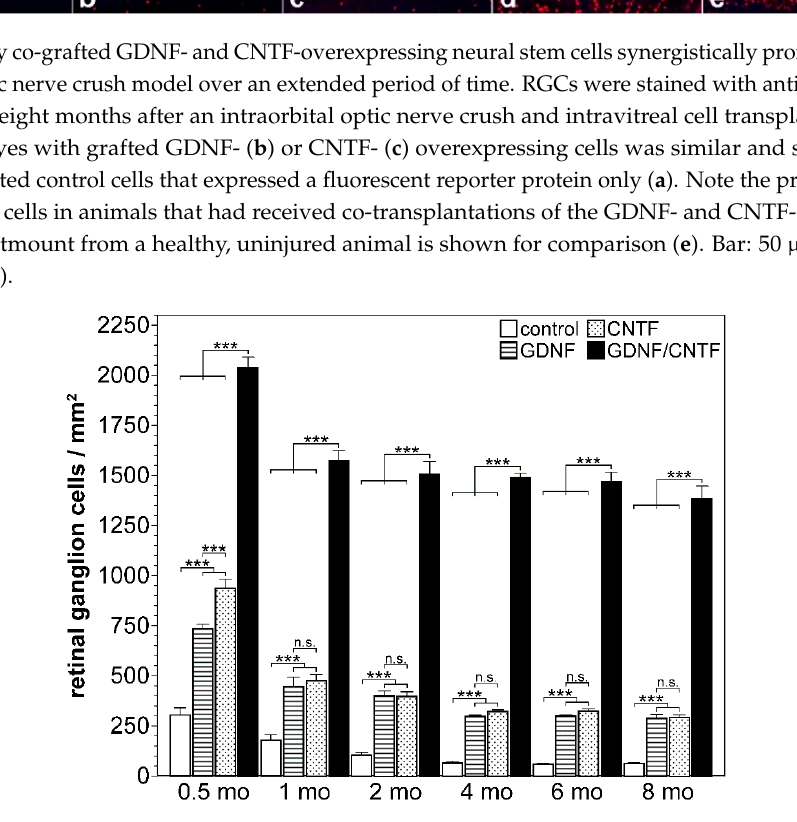
Figure 2. Simultaneous cell-based administration of GDNF and CNTF confers pronounced and long- lasting protection against axotomy-induced cell death. The density of BRN-3A-positive ganglion cells in retinal flatmounts at different time points after an intraorbital optic nerve crush and intravitreal transplantation of control cells (open bars), GDNF- (striped bars), CNTF- (dotted bars), or GDNF- and CNTF- (filled bars) overexpressing neural stem cell lines. The number of viable ganglion cells in GDNF- or CNTF-treated retinas was significantly higher than in control retinas at all post-lesion time points. Note the pronounced rescue of axotomized ganglion cells in retinas simultaneously treated with GDNF and CNTF when compared to retinas treated with either factor alone. Each bar represents the mean (±S.E.M.) of six animals. n.s.: not significant, ***: p < 0.001; two-way ANOVA followed by a Bonferroni post hoc test. Figure adapted from Dulz et al. (2020).